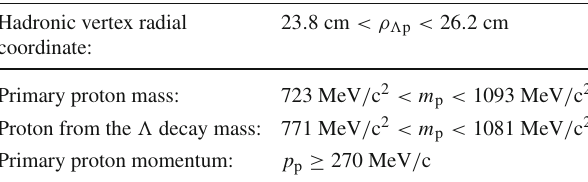
Table 2 Cuts of the optimised (cid:2) p event selection that significantly contribute to the systematic errors. See Fig. 2 for further details about the cuts applied to the mass of the protons Hadronic vertex radial